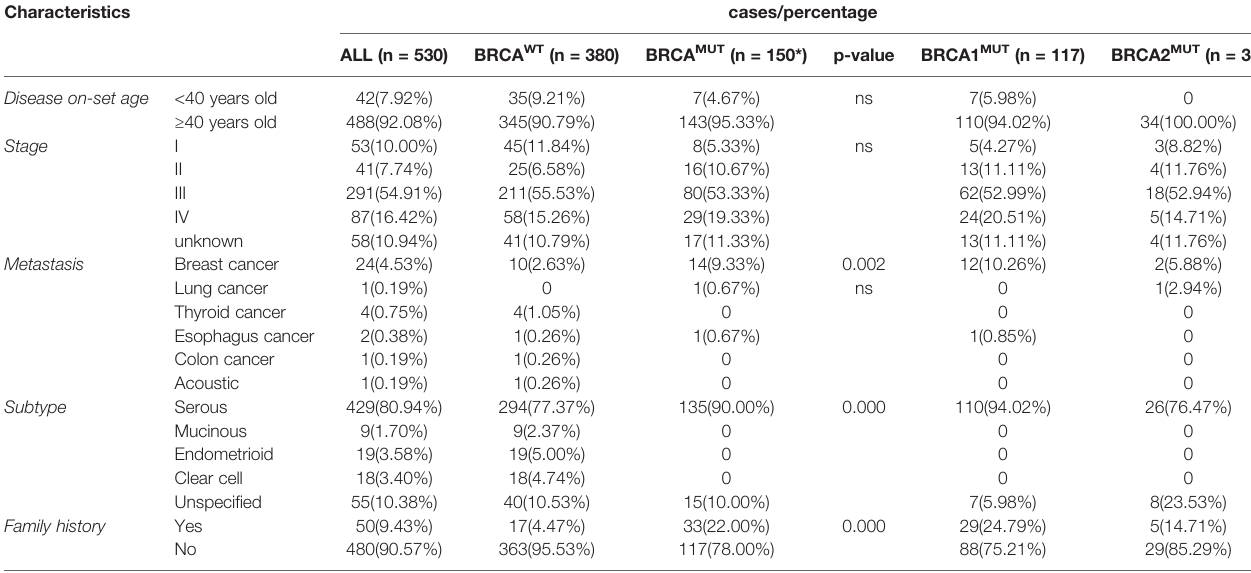
TABLE 1 | Clinical characteristics of 530 Henan ovarian cancer